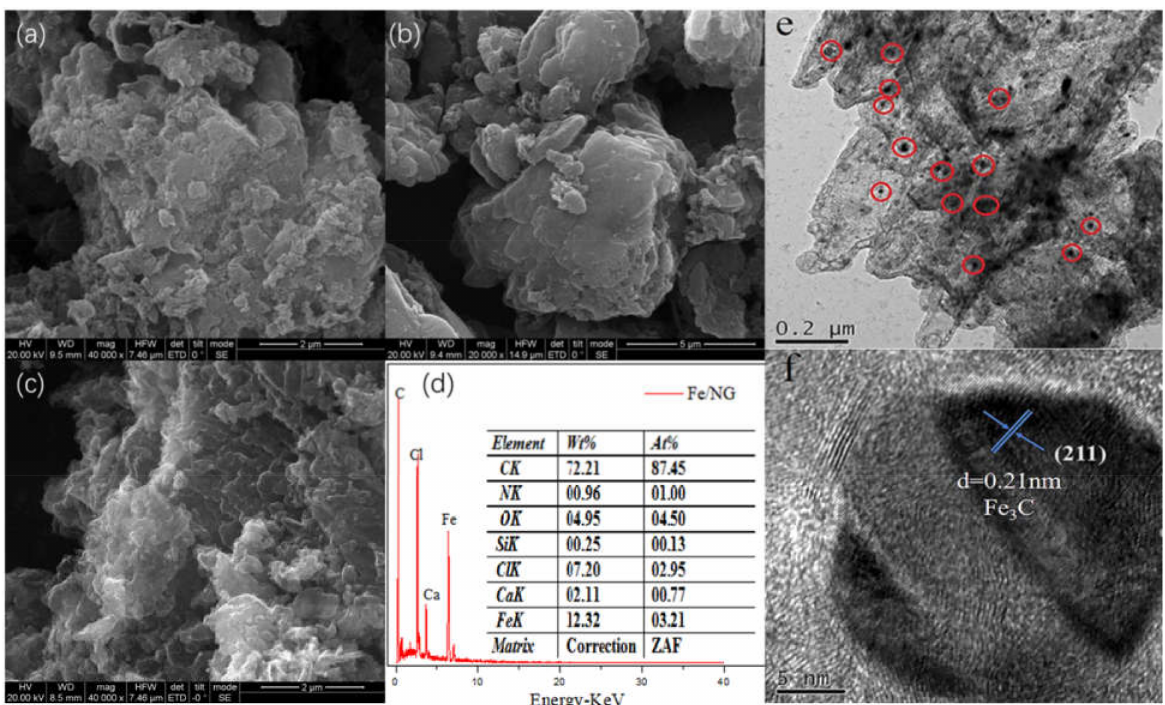
Figure 1. SEM images of ( a ) CN, ( b ) n-CN, ( c ) Fe/NG; ( d ) EDX image; and ( e , f ) HR-TEM images of